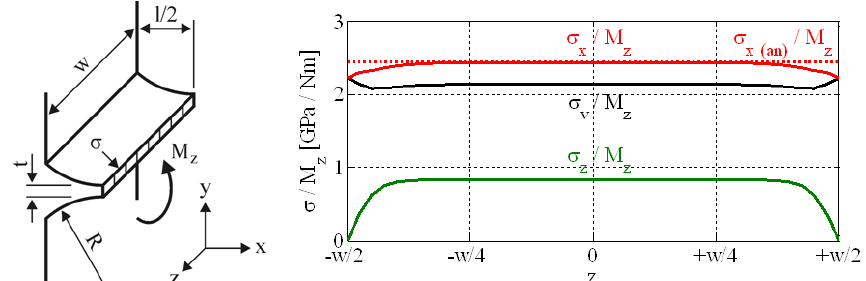
Figure 2. Stress calculated analytically ( σ x( an ) = 6 M z /(wt 2 ) = const.) and with FEM ( σ x , σ z , σ v 6= const.) on the lateral sides of the thinnest cross section ( x = 0, y =± t/ 2, z =− w/ 2 −+ w/ 2, for an origin at the midpoint of a flexure hinge) in the case of pure bending around the pivot axis ( M z = 1Nm). Calculation for the geometry parameters of the specimens: w = 16mm, l = 4mm, R = 3mm, t = 0.4mm.